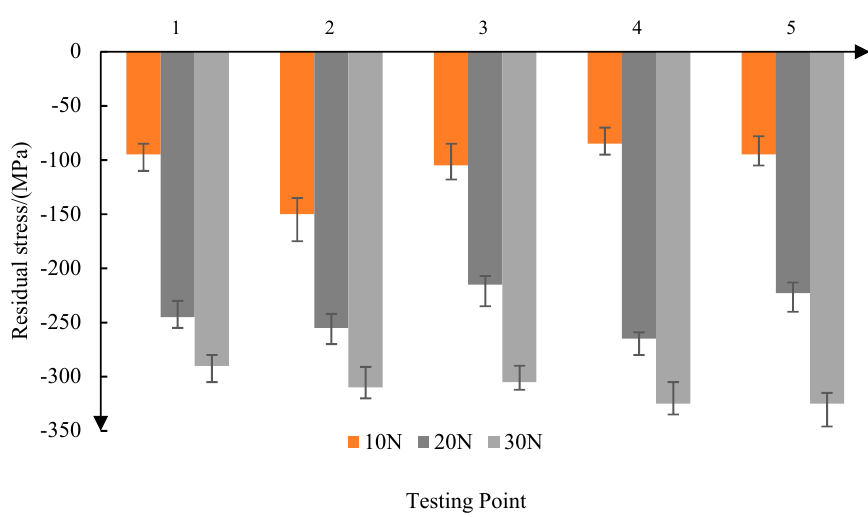
Figure 5. Influence of contact force on residual stress.